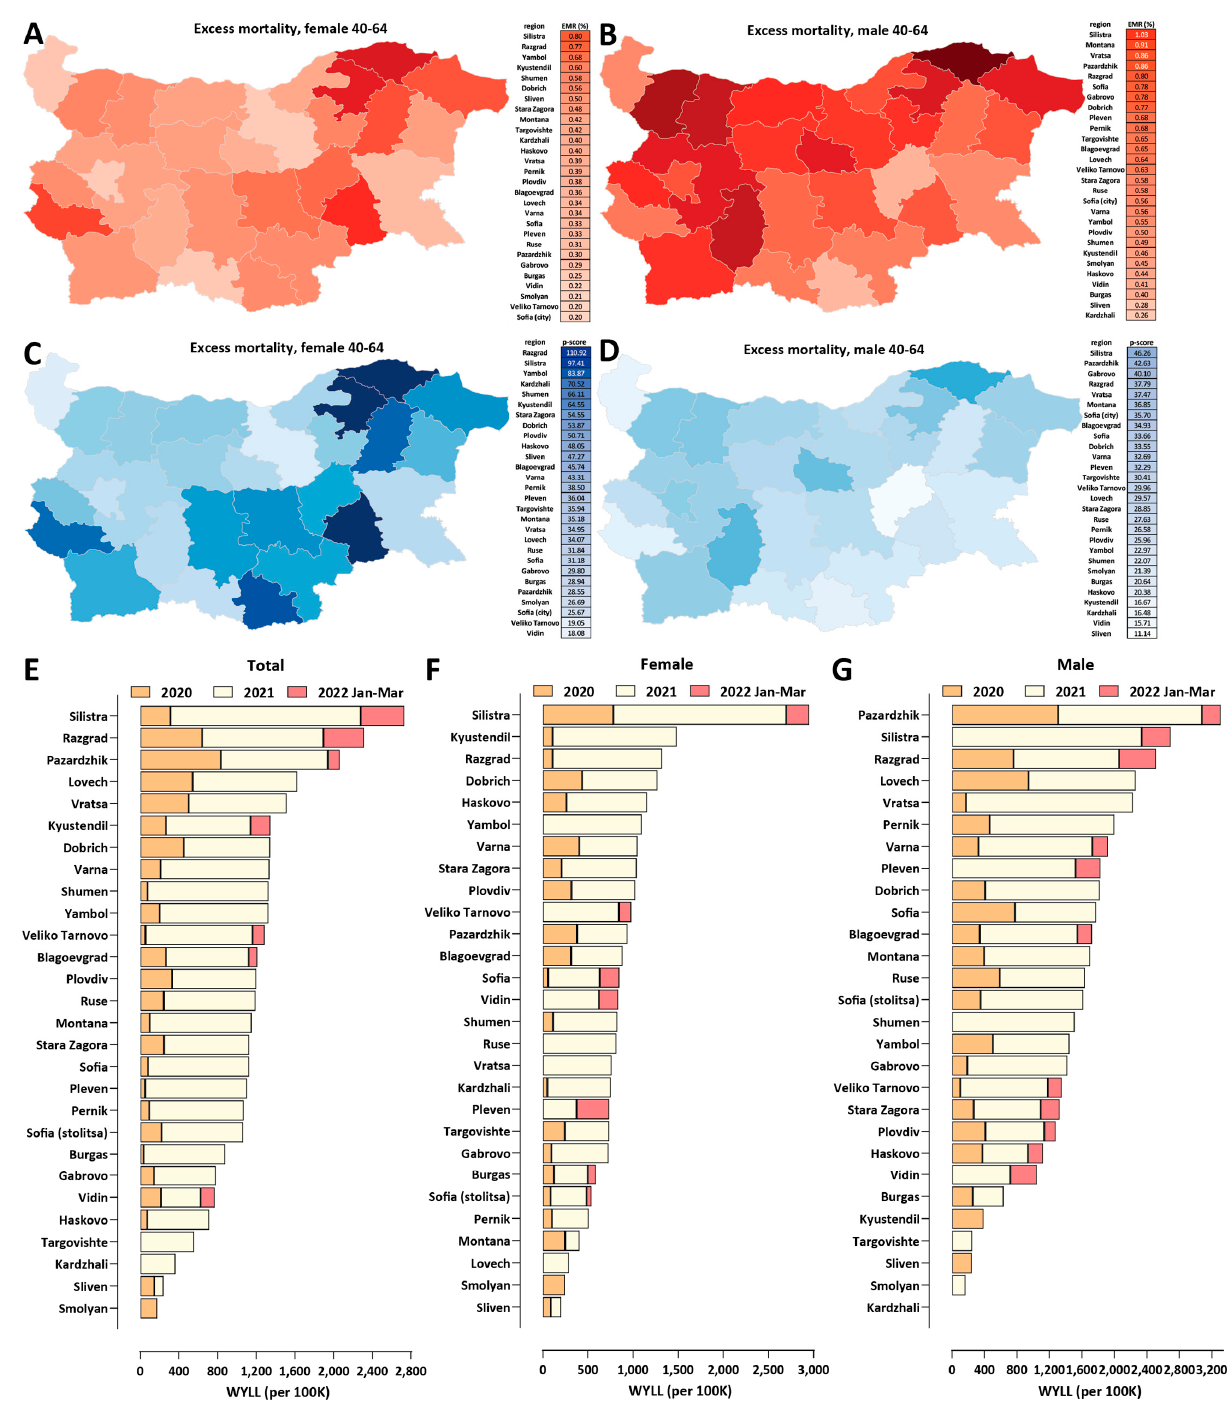
Figure 7. Working-age excess mortality in Bulgaria during the COVID-19 pandemic (up to the end of March 2022) . ( A ) Excess mortality by region, for females ages 40–64, EMR values; ( B ) excess mortality by region, for males ages 40-64, EMR values; ( C ) excess mortality by region, for females ages 40-64, P-scores; ( D ) excess mortality by region, for males ages 40–64, P-scores; ( E ) standardized WYLL values, in total; ( F ) standardized WYLL values, for females; ( G ) standardized WYLL values, for males.